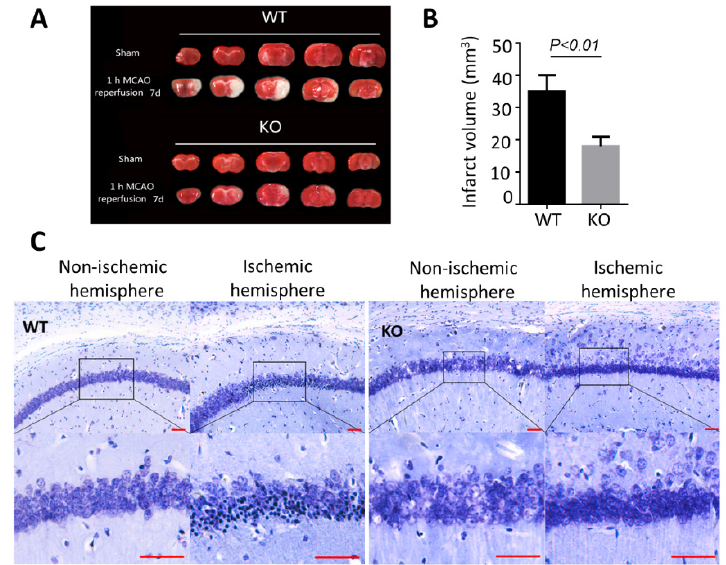
Figure 2. BNIP3 knockout mice have less cerebral damage compared with wild-type mice. ( A ) TTC staining sections of wild-type and BNIP3 knockout 7 days after MCAO. ( B ) Quantitative analysis of ischemic volume based on TTC staining. ( C ) Cresyl Violet Staining (Nissl Staining) staining showed numerous degenerated neurons in CA1 areas. Results shown represent mean ± SD., n = 4. Bar, 50 μ m.